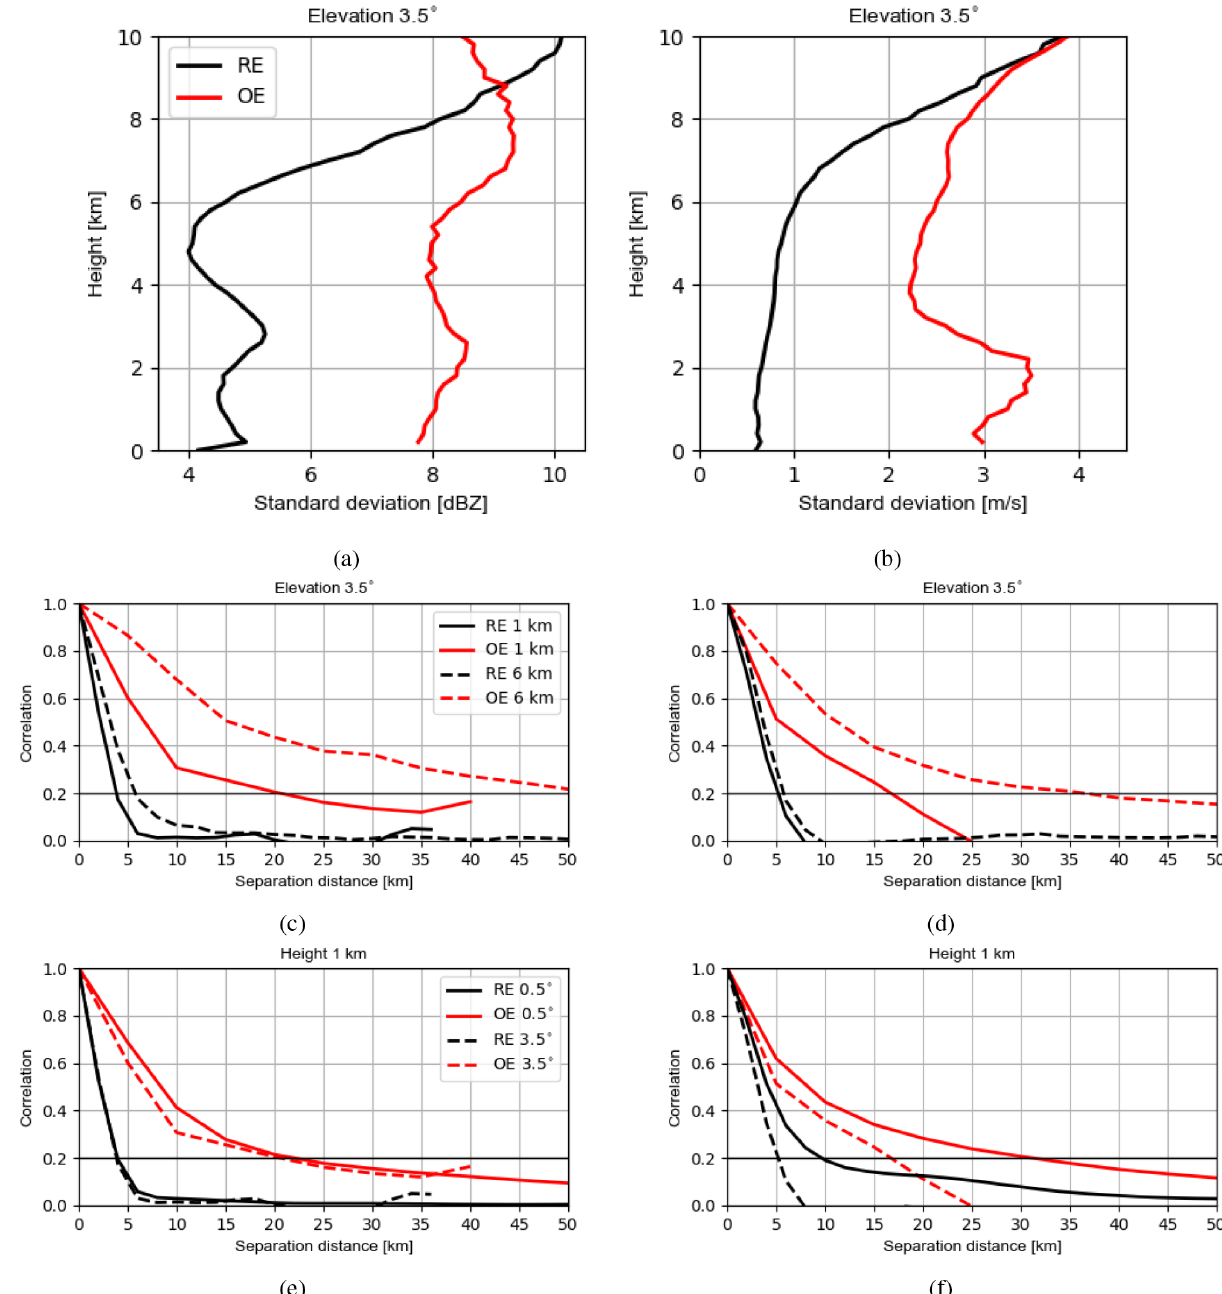
Figure 13. (a) Vertical profiles of the estimated standard deviations of the RE and OE at an elevation of 3 . 5 ◦ for reflectivity data ≥ 5dBZ and (b) radial wind. (c) The estimated horizontal correlations for the RE and OE at an elevation of 3 . 5 ◦ at heights of 1 and 6km for reflectivity data ≥ 5dBZ and (d) for the radial wind. (e) The estimated horizontal correlations for the RE and OE at a height of 1km for elevations of 0 . 5 and 3 . 5 ◦ for reflectivity data ≥ 5dBZ and (f) for the radial wind.